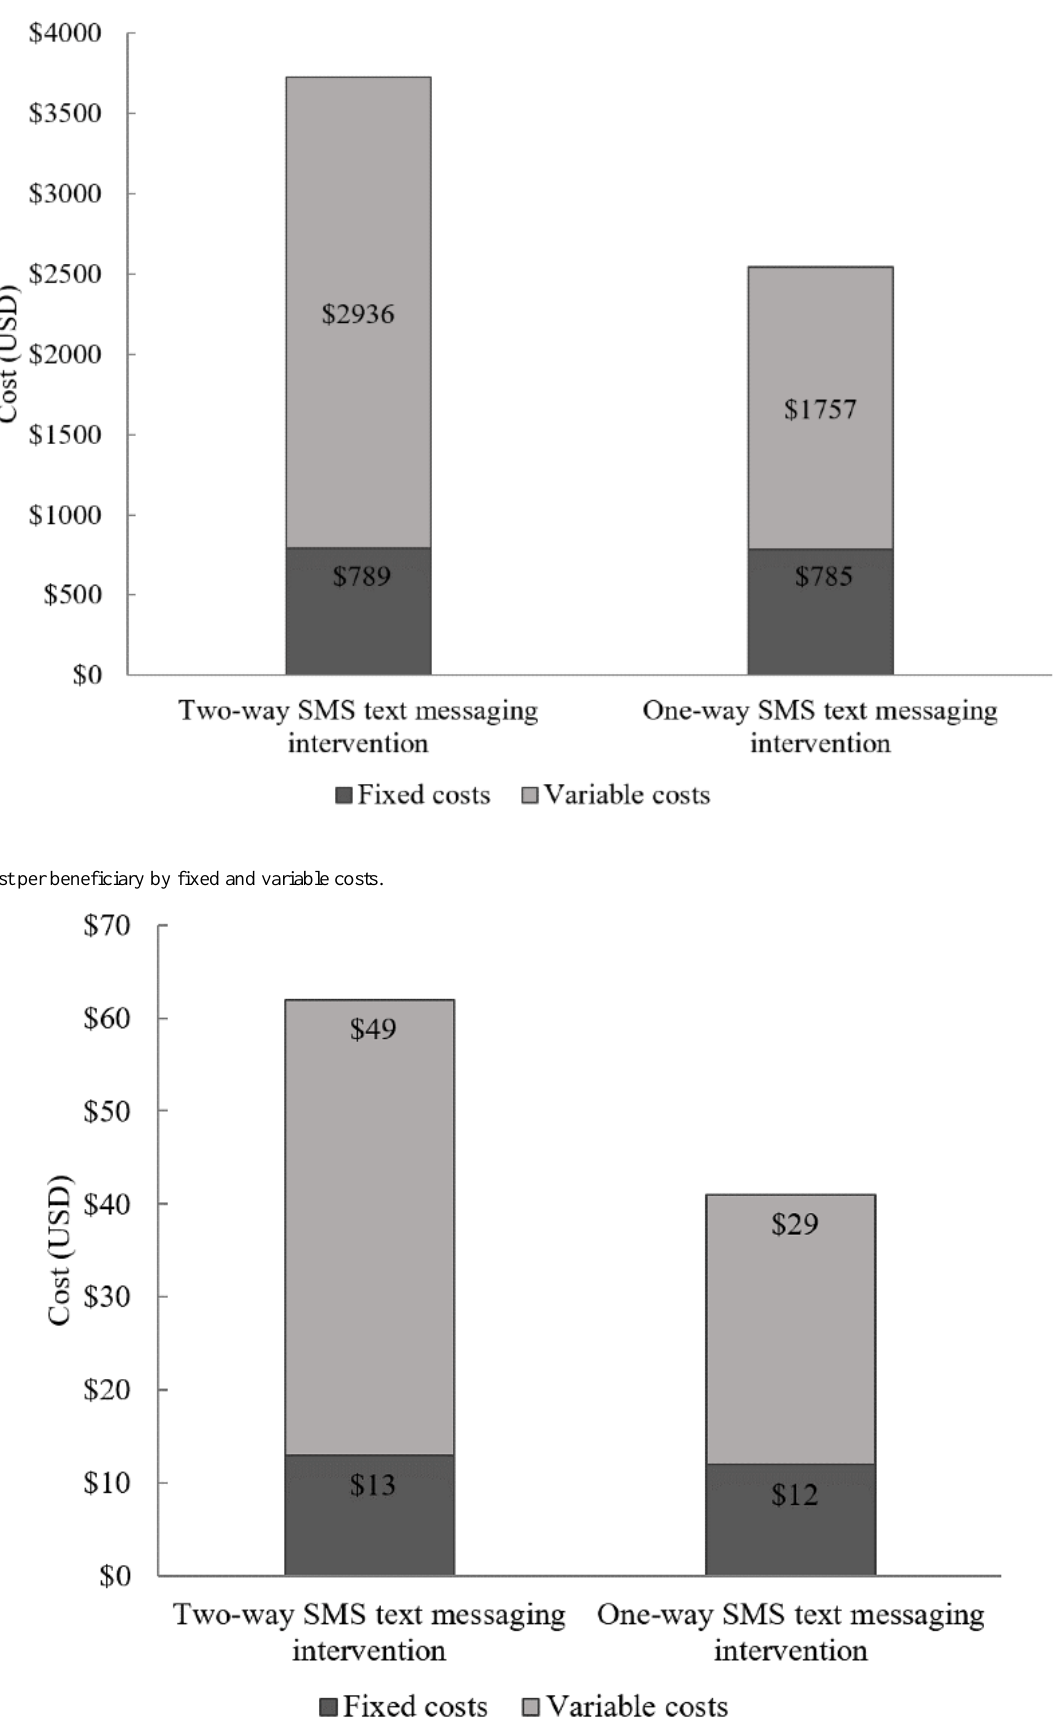
Figure 1. Total annual incremental costs by fixed and variable costs.